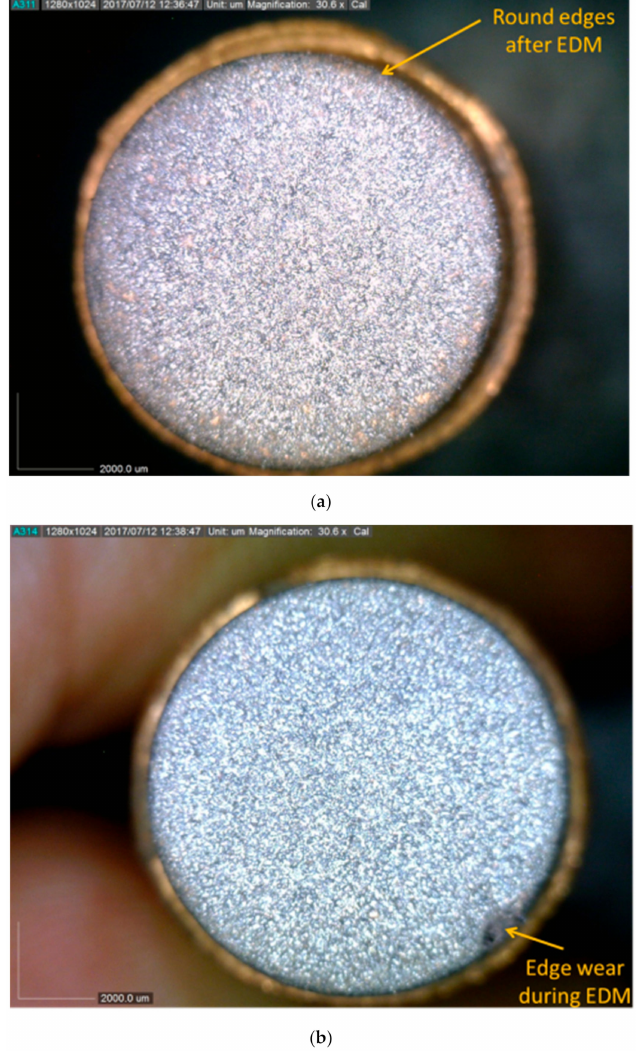
Figure 17. ( a ) Change in shape of tool tip after EDM. ( b ) Change in tool tip due to wear.